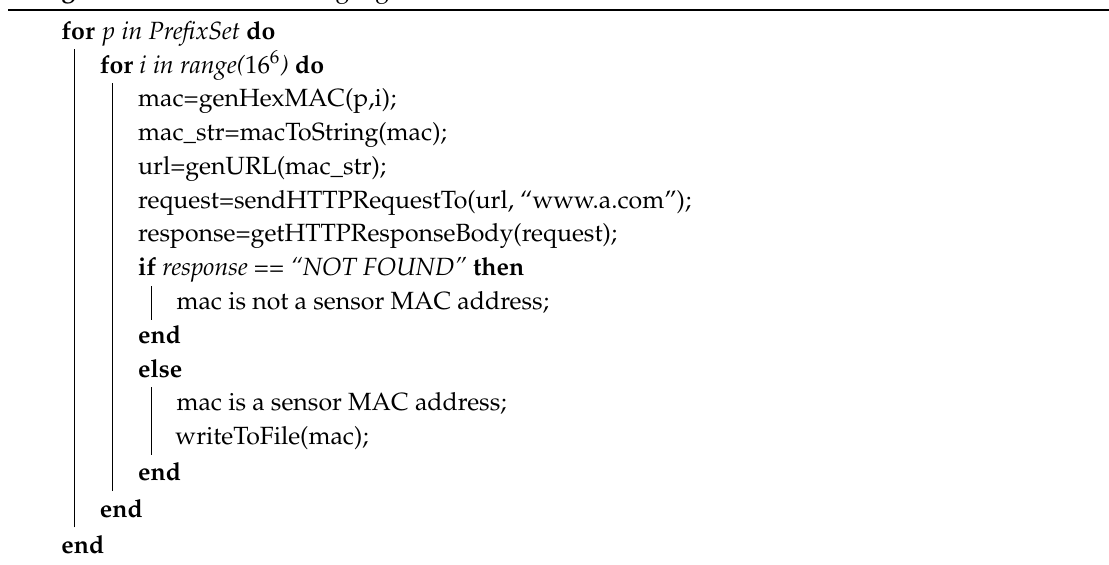
Algorithm 1. MAC scanning